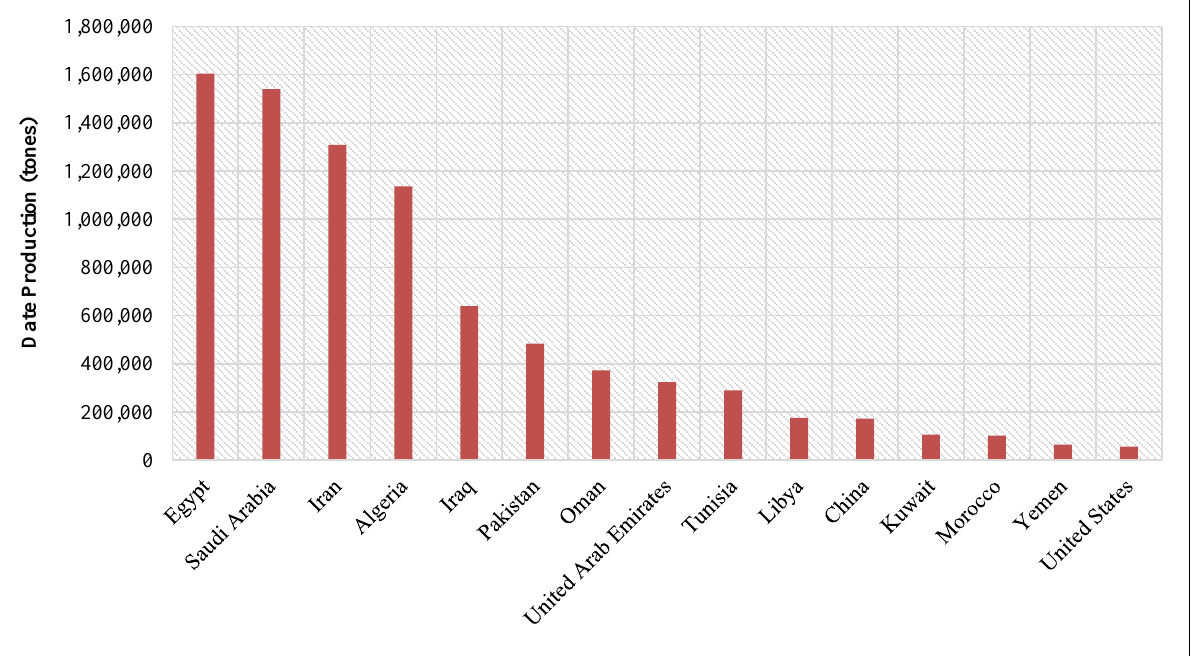
Figure 1. Top Countries in Dates Production (FAO 2019)